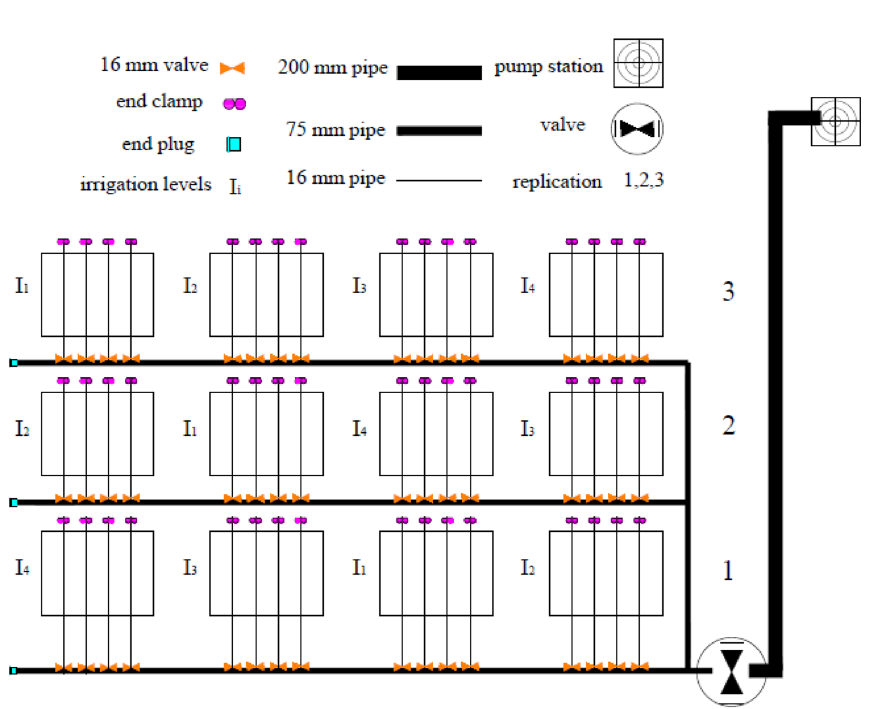
Figure 1. Plot layout of field